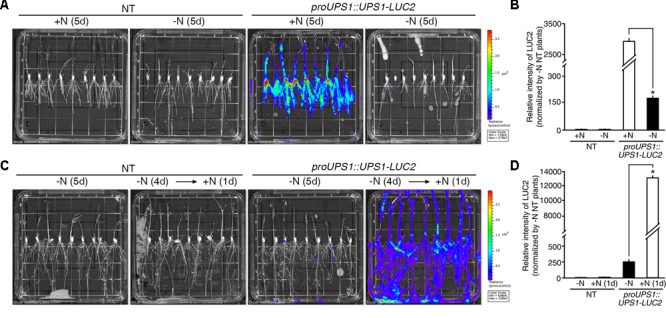
Luminescence resulting from proUPS1::UPS1-LUC2 is strong under high N conditions. (A) Images of 5-day-old NT (non-transgenic) and proUPS1::UPS1-LUC2 plants grown on GM+N (growth media +N) or GM–N. (B) Relative intensity of the luminescence in T3 homozygous proUPS1::UPS1-LUC2 plants under the same conditions as in (A). (C) Images of 5-day-old NT and proUPS1::UPS1-LUC2 plants grown on GM–N for 5 days, or grown on GM–N for 4 days followed by addition of 100 mM ammonium nitrate for 1 day. (D) Relative intensity of the luminescence in T3 homozygous proUPS1::UPS1-LUC2 plants under the same conditions as in (C). Data shown are the mean + SD of 5 T3 homozygous proUPS1::UPS1-LUC2 lines (n = 10 for each line). NT plants grown on GM–N were used as a control for normalization. Asterisks indicate significant differences based on a 95% confidence interval by a Student’s t-test.